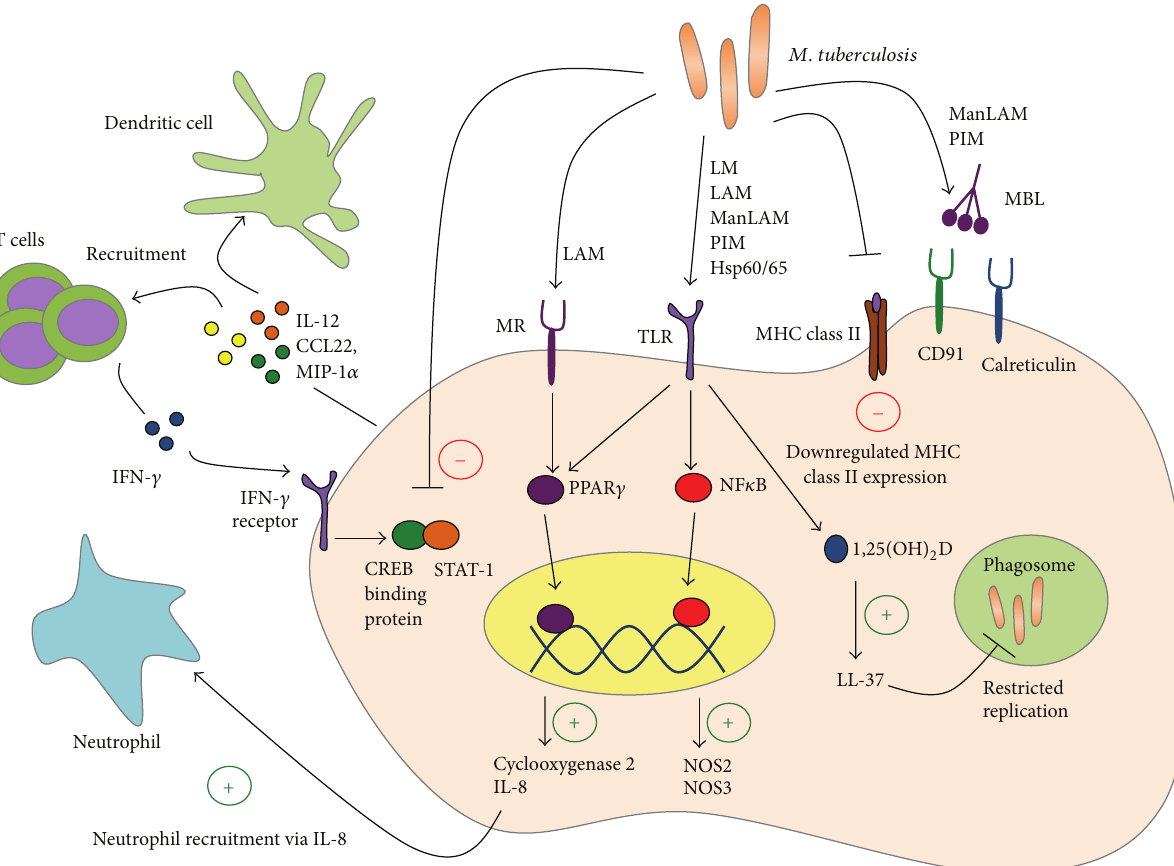
Figure 1: Human alveolar macrophages possess an array of receptors to recognize M. tuberculosis (Mtb). In response to Mtb infection, macrophages upregulate effector and signalling pathways to both prevent bacterial replication and recruit other immune cells into the site of infection. M. tuberculosis components, including lipoarabinomannans (LAMs), lipomannans (LMs), phosphatidylinositol mannosides (PIMs), and heat shock proteins (HSPs), are recognized by a variety of pattern recognition receptors. Following recognition of Mtb, host effectors, such as NF- 𝜅 B and PPAR 𝛾 , are activated to upregulate antimicrobial factors. These antimicrobial peptides (e.g., LL-37) possess both effector and signalling functions to actively interfere with bacterial replication as well as recruit and activate neutrophils, dendritic cells, and T cells. However, Mtb interferes with macrophage effector and signalling pathways. Most importantly, Mtb downregulates MHCIIexpression on macrophages to prevent optimal interaction with antigen specific T-cells. Furthermore, Mtb interferes with IFN 𝛾 signaling, a T cell cytokine mediator critical for upregulating the inherent antimicrobial capacity of macrophages during infection.